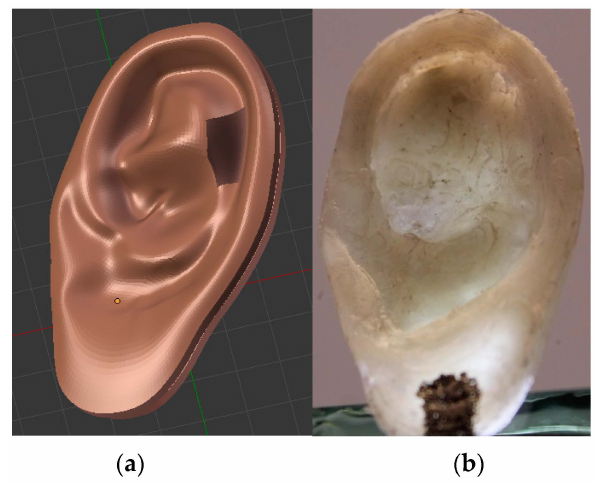
Figure 5. ( a ) Human ear created with a 3D CAD program. ( b ) Ear prosthesis printed from PVDF. The ear was printed in polyvinylidene fluoride, as it exhibits ferroelectric properties. Figure 5b shows the 3D-printed ear prosthesis. The dimensions of the printed ear are 60.1 mm wide by 34.74 mm long, and it has an average thickness of 6.88 mm. Two square electrodes of a side of 6.26 mm were painted over the printed ear with silver paint (mark SPI-Supplies). The electrodes are 41 mm apart